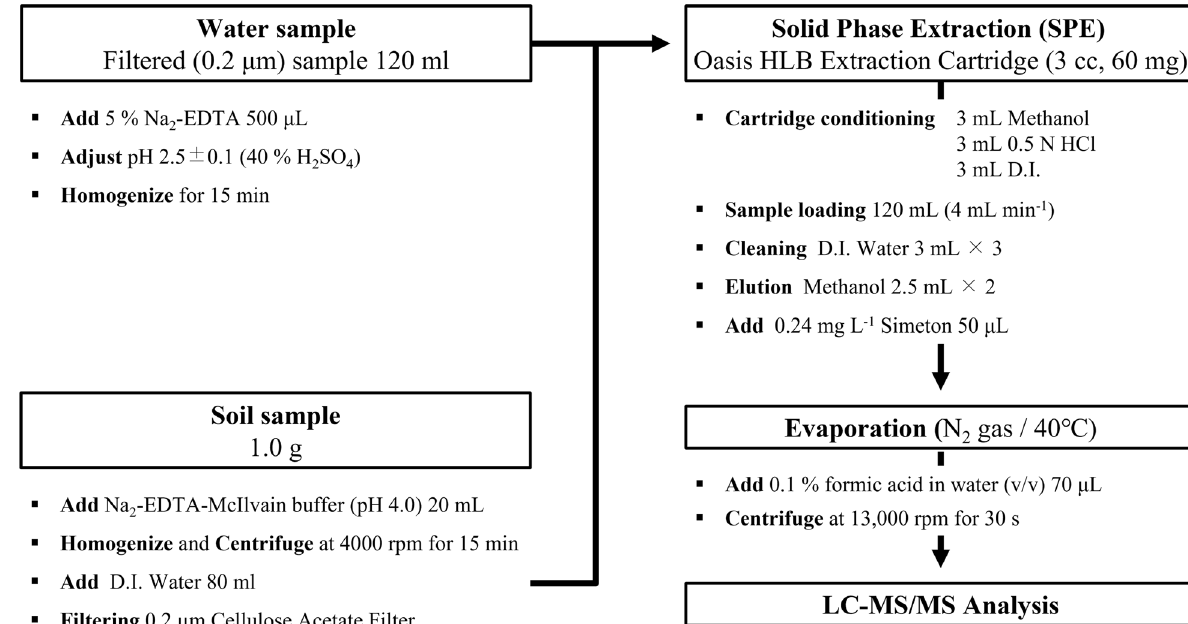
Fig. 1 Flow diagram of analytical method for veterinary antibiotics in river water and